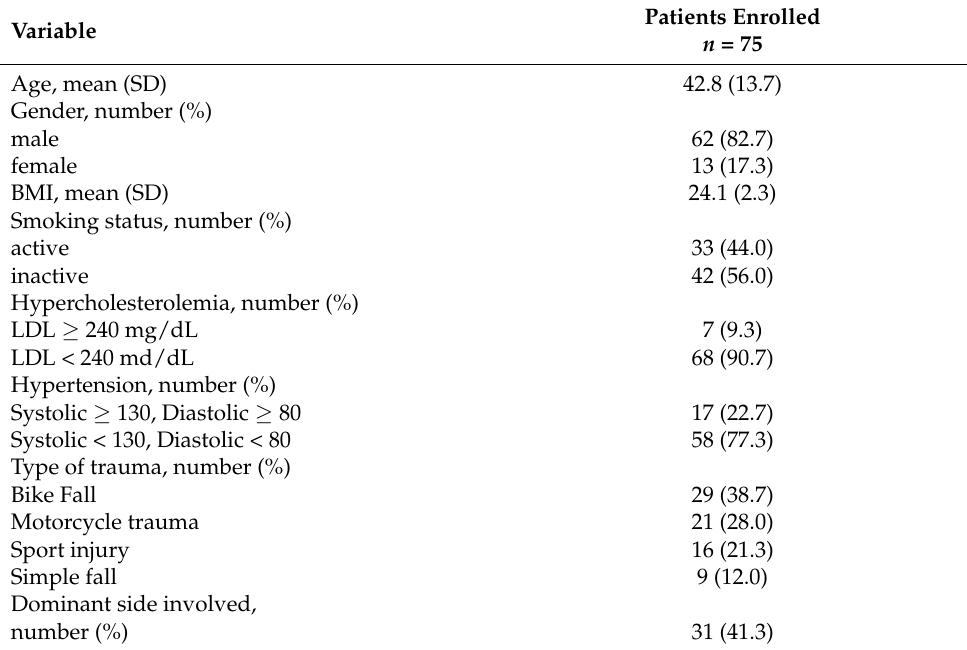
Table 1. Demographic and clinical characteristics of overall